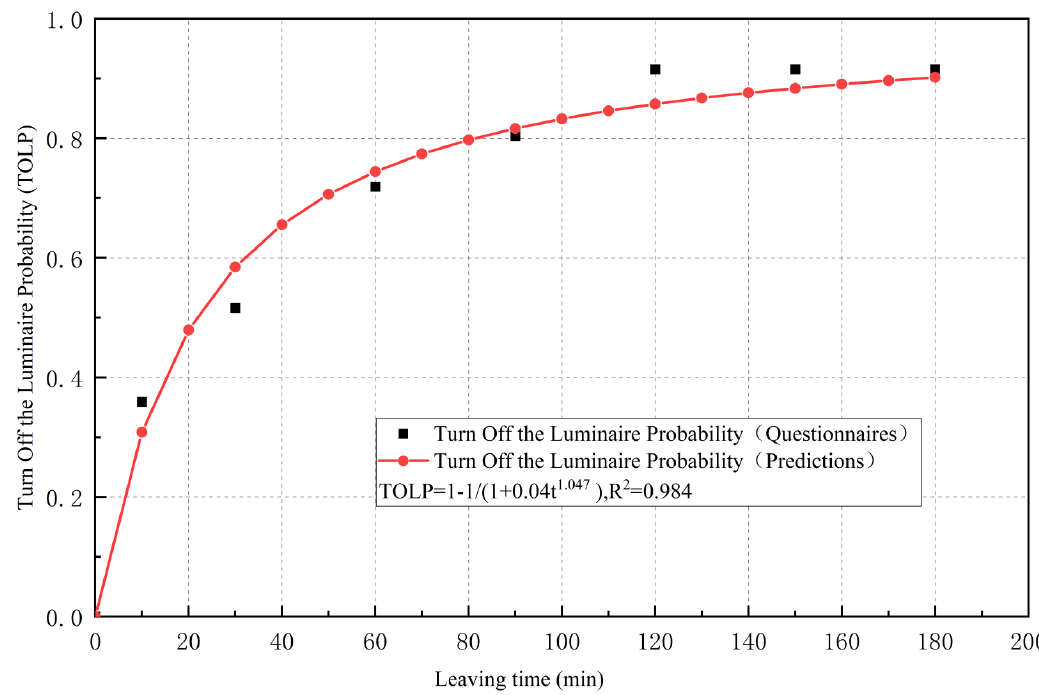
Figure 14. Probability of the lights being turned off with the departure duration.